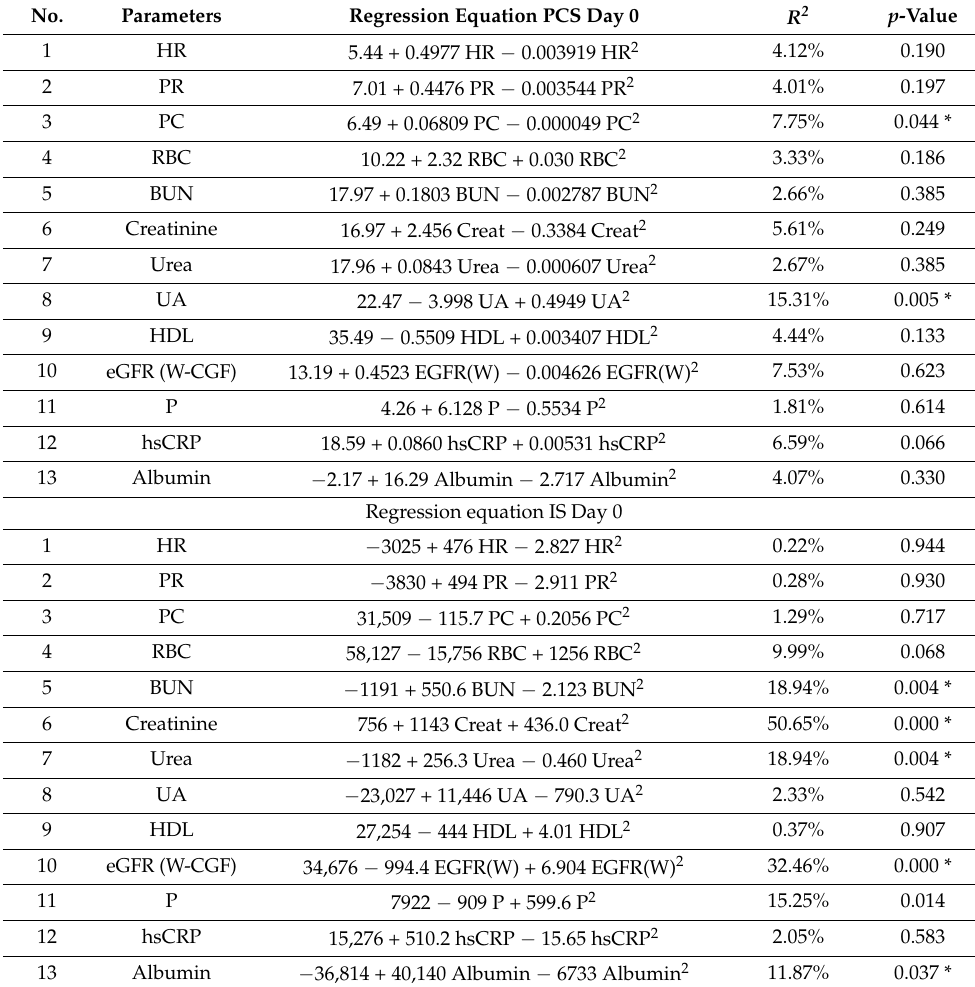
Table 6. The correlation of PCS and IS with uremic